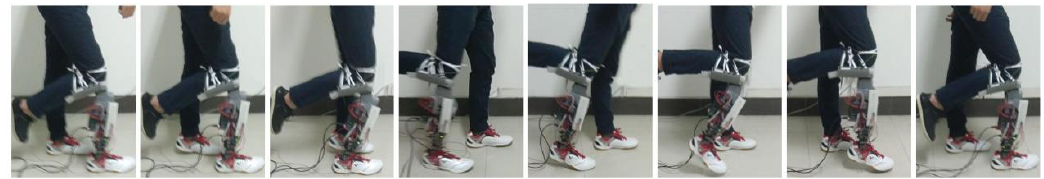
Figure 18. One gait cycle of the experimental level-ground walking.